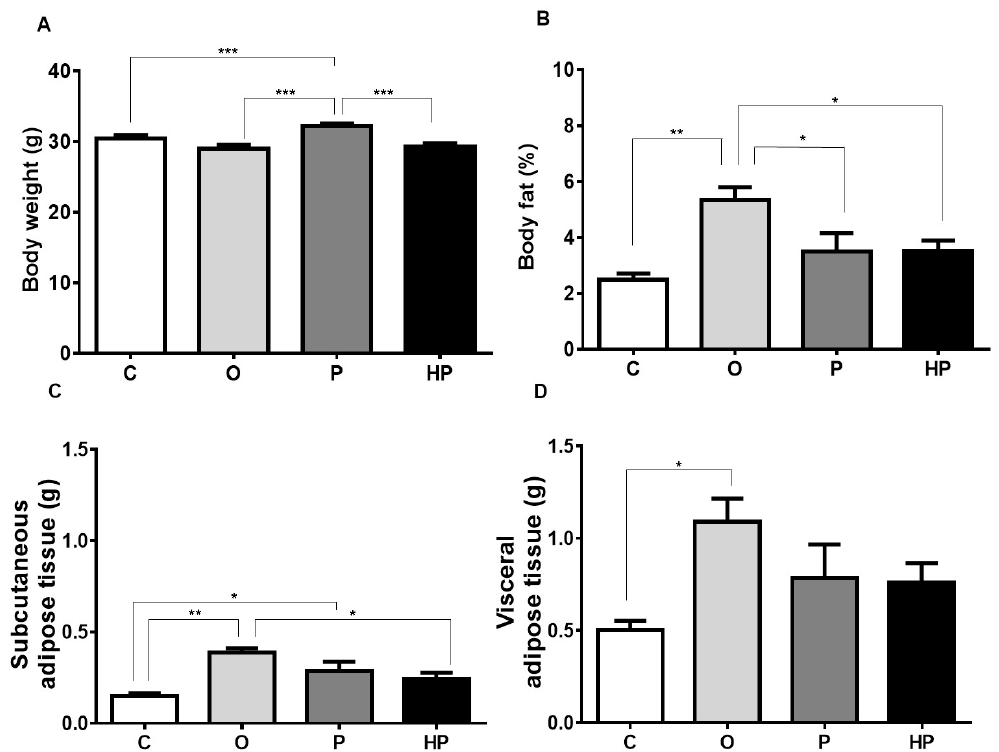
Figure 1. Impact of experimental diets on animals’ body weight ( A ), body fat ( B ), subcutaneous adipose tissue ( C ), and visceral adipose tissue ( D ). Data expressed as mean ± standard error of the mean ( n = 6). * p ≤ 0.05; ** p ≤ 0.01; *** p ≤ 0.001. C = control group; O = olive oil group; P = palm oil group; HP = hybrid palm oil group.